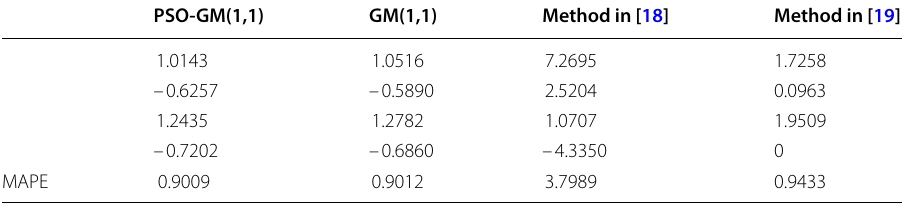
Table 6 Percentage forecast errors associated with the various models for energy data for a